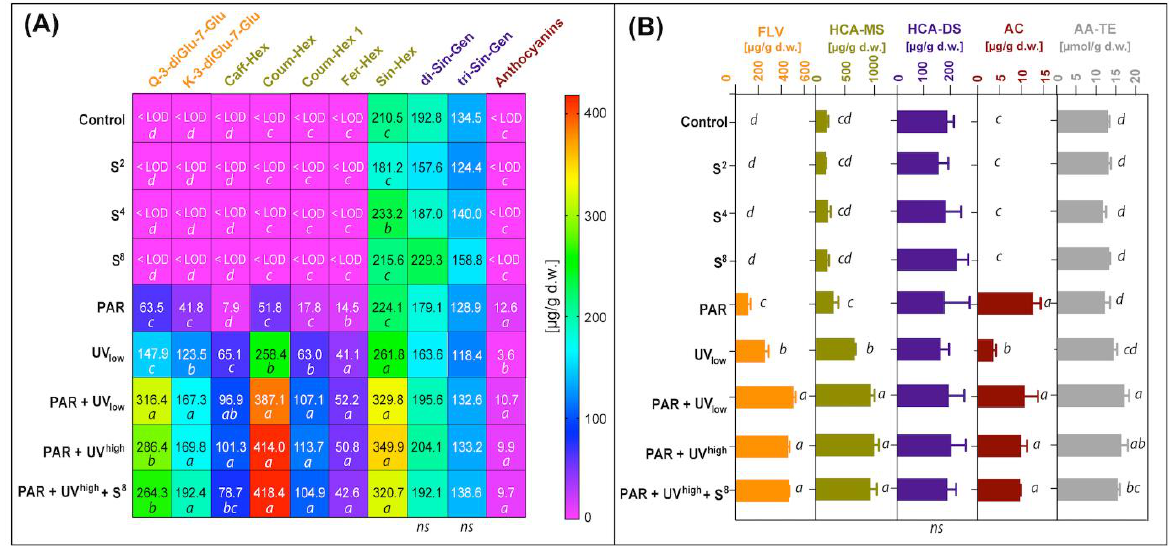
Figure 3. The contents of ( A ) major individual phenolic compound combined with ( B ) the content of total flavonols (FLV), hydroxycinnamate monosaccharides (HCA-MS), hydroxycinnamate disaccharides (HCA-DS), anthocyanins (AC), and total antioxidant activity expressed as Trolox equivalents (AA-TE) determined in treated and untreated white cabbage samples. Treatment codes are given in Table 1. The names of analytes are abbreviated as follows: Q-3-diGlu-7-Glu, quercetin 3-diglucoside-7-glucoside; K-3-diGlu-7-Glu, kaempferol 3-diglucoside-7-glucoside; Caff-Hex, caffeoyl-hexoside; Coum-Hex, coumaroyl-hexoside; Fer-Hex, feruloyl-hexoside; Sin-Hex, sinapoyl-hexoside; di-Sin-Gen, disinapoyl-gentiobioside; tri-Sin-Gen, trisinapoyl-gentiobioside, LOD, limit of detection. The results marked as ns , not significant, refer to a comparison of treatments within each column by ANOVA (P ≤ 0.05). Numbers followed by the same letters within one column/parameter are not significantly different according to Tukey’s multiple comparison test at P ≤